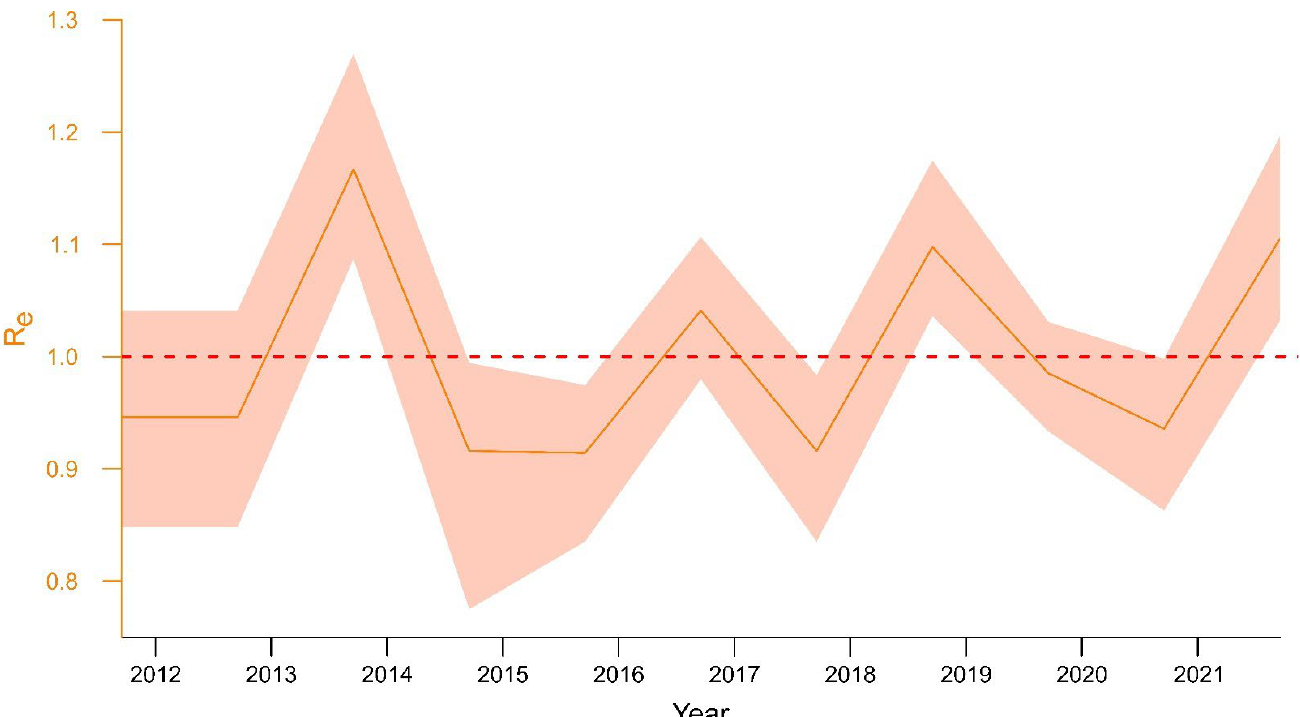
Figure 5. Birth–death skyline serial analysis of WNV L2 sequences of the identified Italian clade. Reproductive number (Re) is plotted for a timespan that goes from 2012 to 2021. (Re) > 1 indicates a growth of the epidemic.